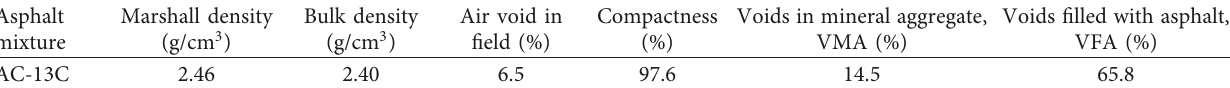
Table 2: Volumetric parameters of the asphalt